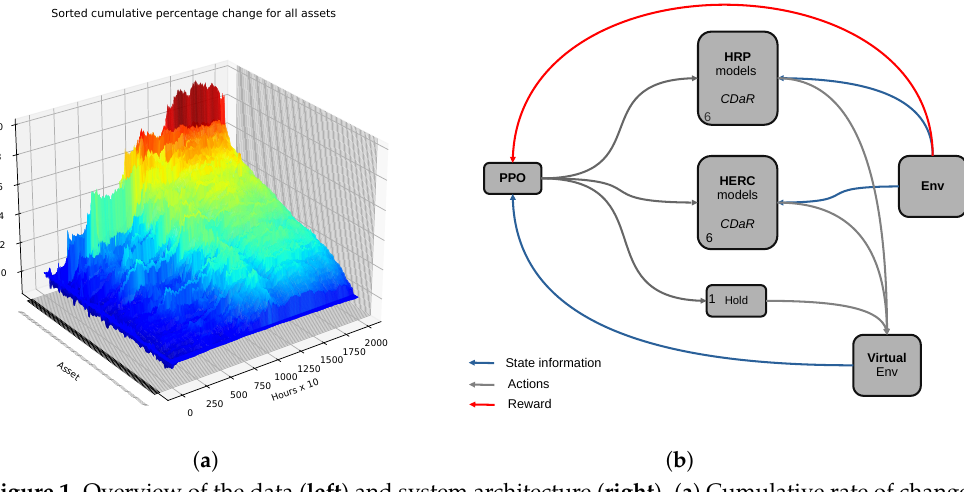
Figure 1. Overview of the data ( left ) and system architecture ( right ). ( a ) Cumulative rate of change of all assets in the portfolio; ( b ) Overview of the system